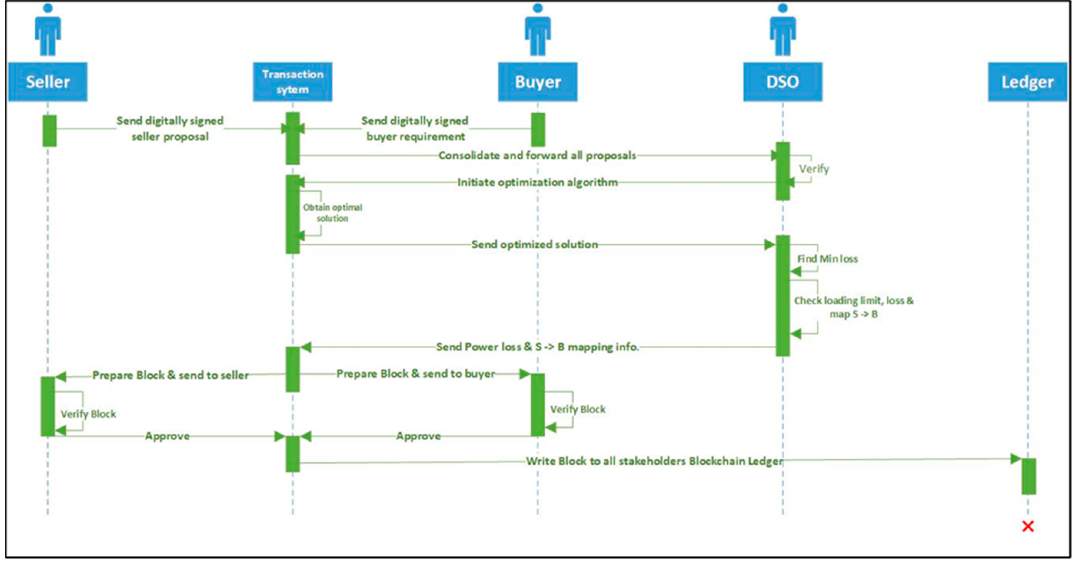
Figure 5. Sequence diagram of the energy transaction.